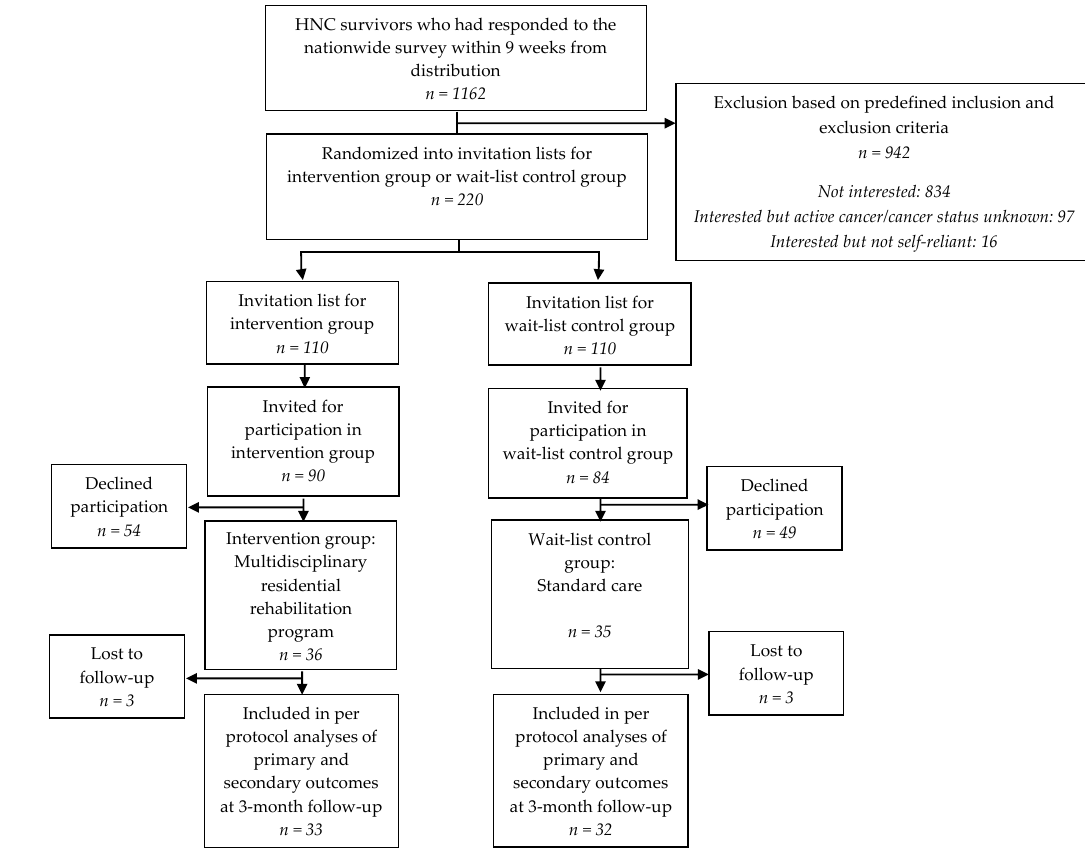
Figure 2. Flow chart of the NUTRI-HAB trial from baseline to 3-month follow-up.